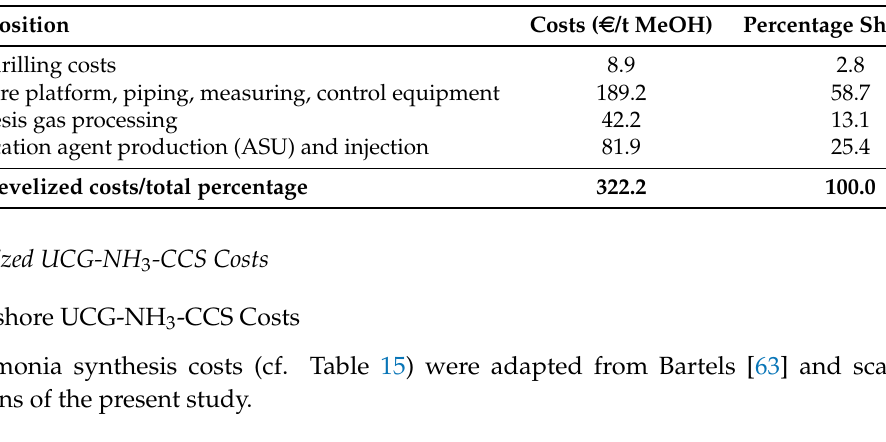
Table 15. Ammonia production CAPEX/OPEX for 20 years of operation (plant size of 314 kt/year).